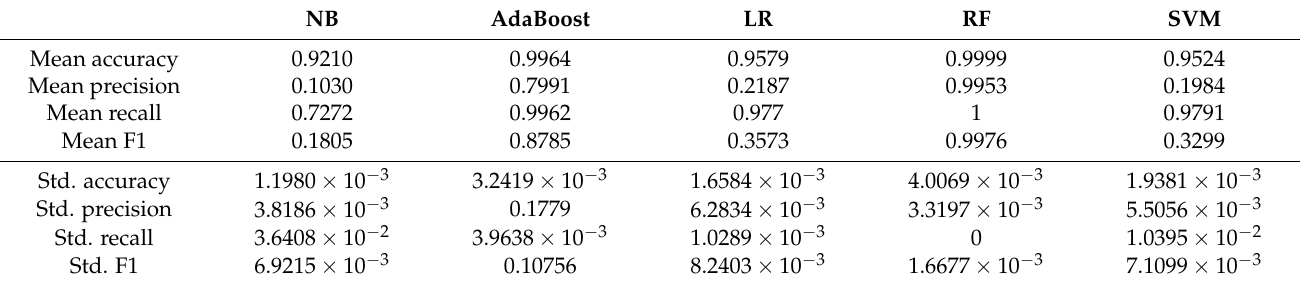
Table 10. Best scoring model by